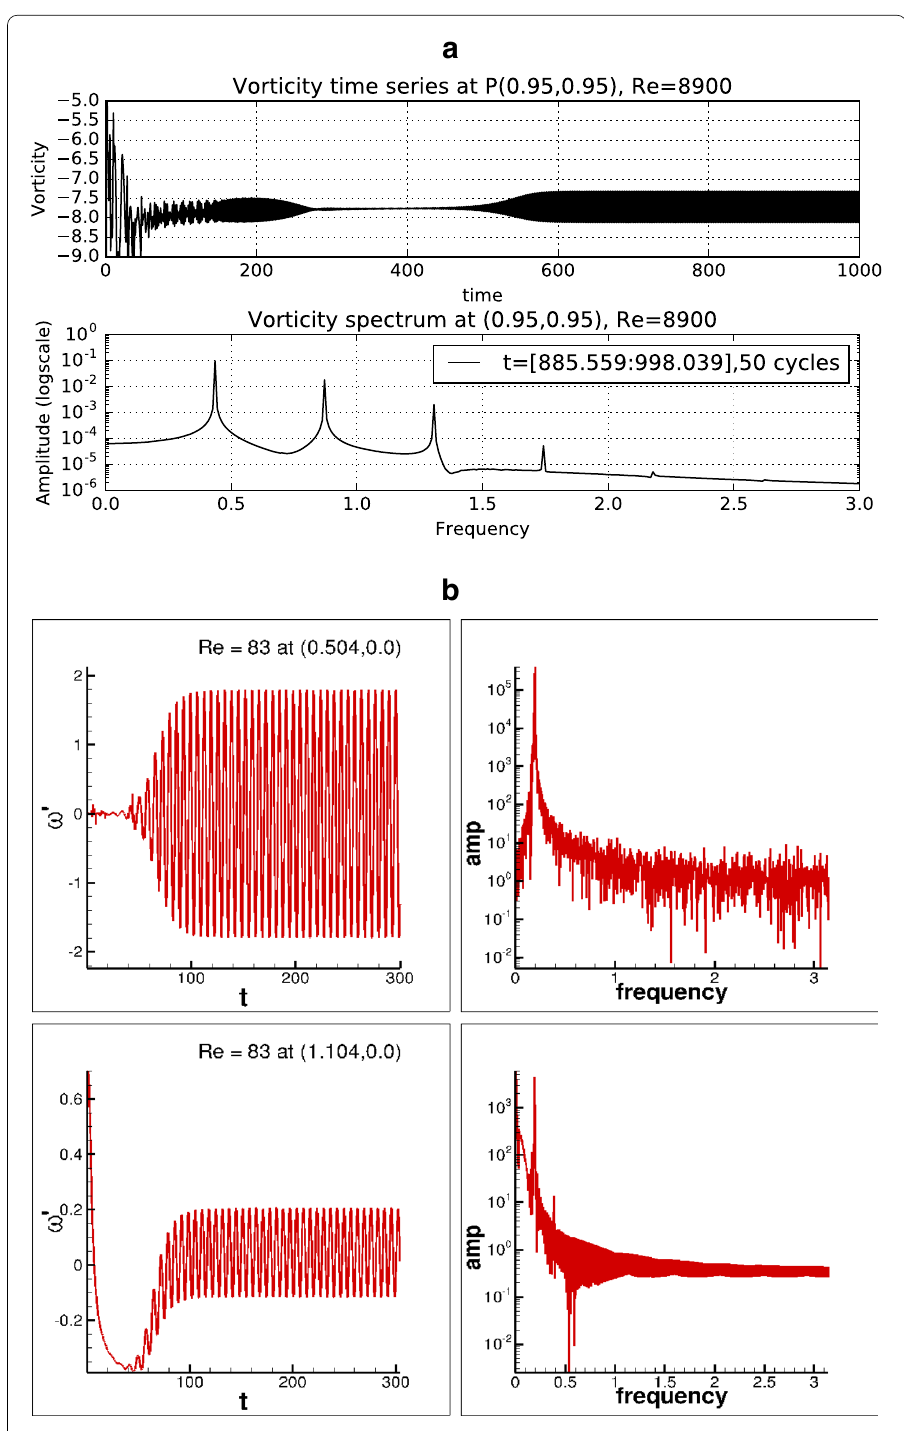
Fig. 1 DNS time series and their associated FFT’s are shown for a the flow inside a LDC and b the external flow past a cylinder, at indicated points in the flow